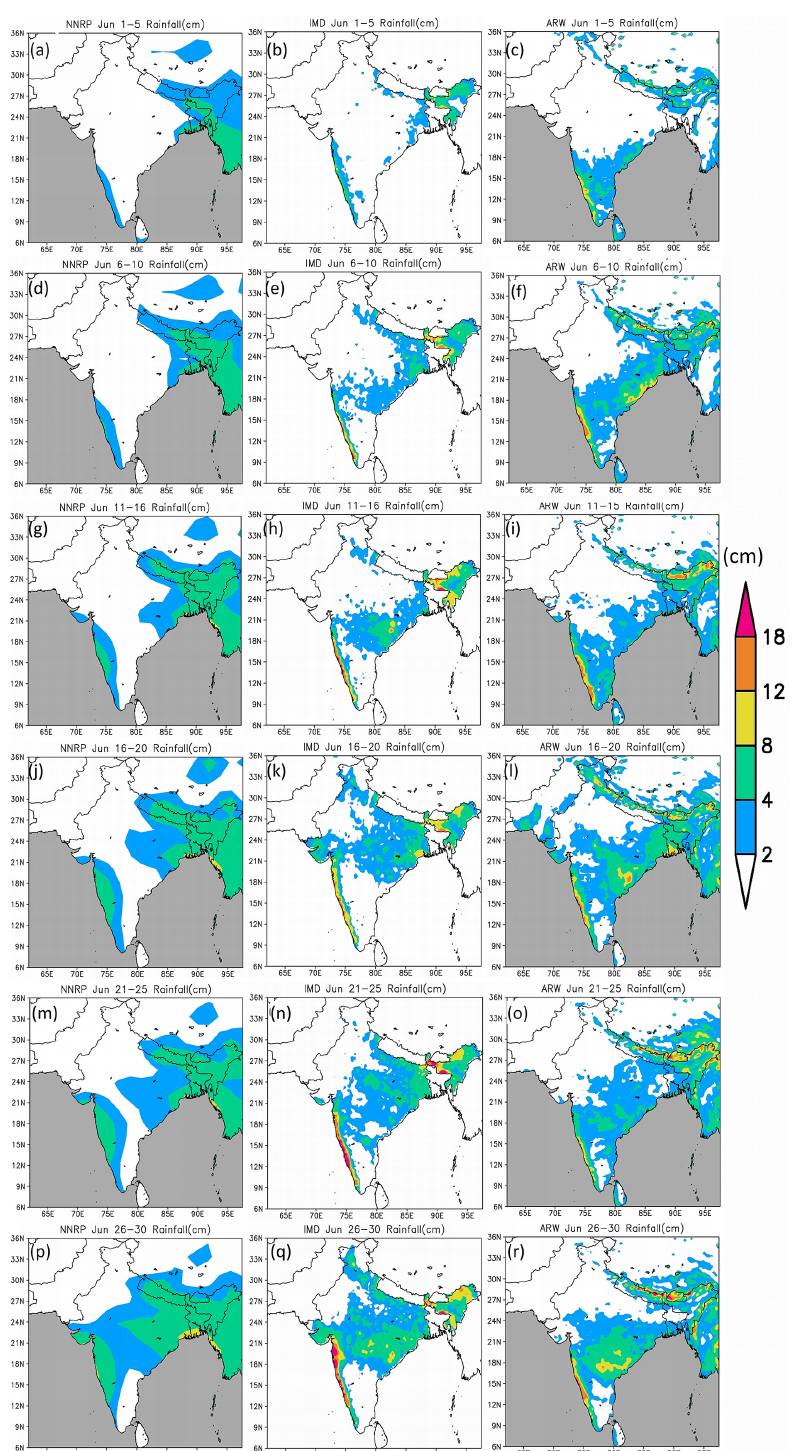
Figure 5. Spatial distribution of 10-year mean 5-day accumulated rainfall (in cm) (a, b, c) 1–5 June (d, e, f) 6–10 June (g, h, i) 11–15 June (j, k, l) , 16–20 June (m, n, o) , 21–25 June and (p, q, r) 26–30 June derived from NNRP reanalysis, IMD rainfall data and simulation, respectively. Left panels are for NNRP, middle panels are for IMD and right panels are for ARW